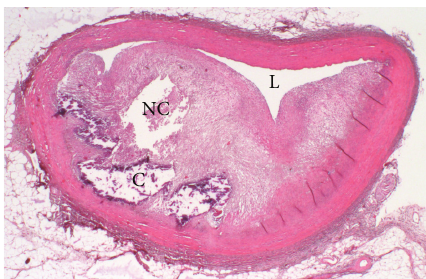
Figure 3: Photomicrograph of a high-grade coronary atheroscle- rotic lesion obtained from a 13-month PCSK9 gain-of-function mutant pig fed a high cholesterol diet. C: calcifications; L: lumen; NC: necrotic core; Photomicrograph kindly provided by Dr. Erling